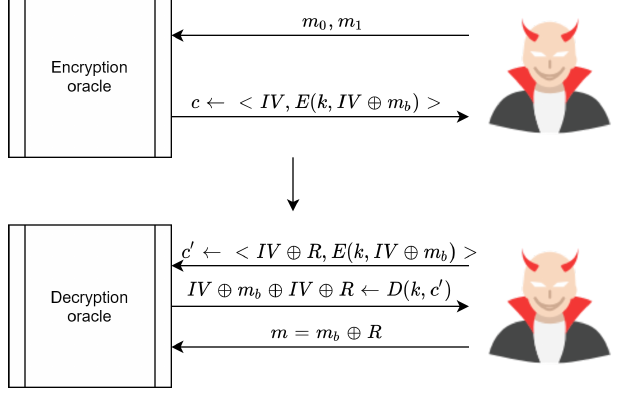
Figure 25. Steps needed for an adversary to win the CCA challenge.